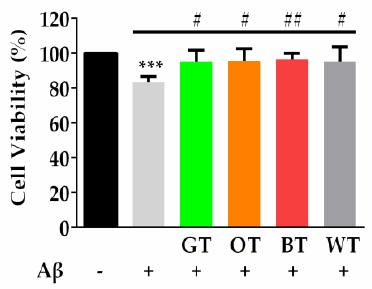
Figure 3. MTT assay of cell viability in response to 48 h incubation with Aβ (0.5 µM), alone or in the presence of each tea extract (100 μg/mL ). *** p < 0.001, vs Control. # p <0.05, ## p < 0.01 vs Aβ. Results were expressed as mean ± standard deviation ( n = 6).